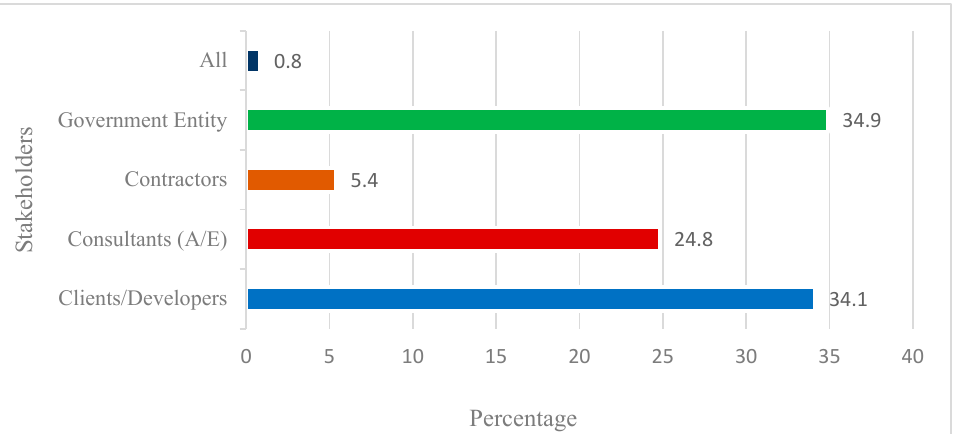
Figure 2. The stakeholders that the respondents believe has the greatest influence in determining how sustainable the construction project will be.